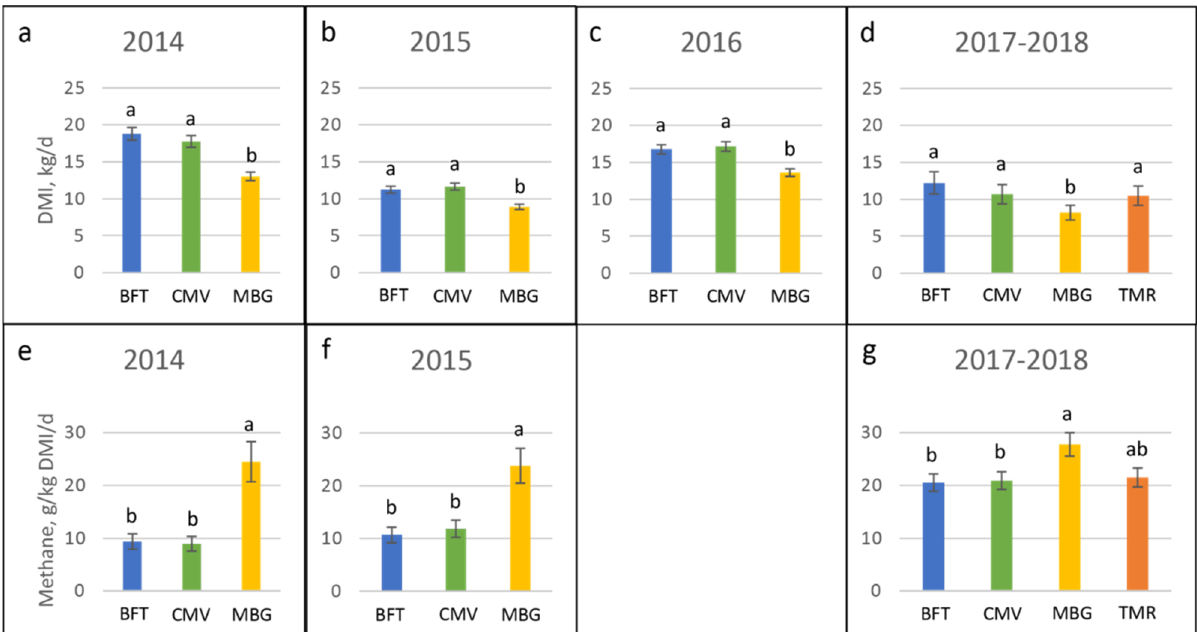
Figure 3. ( a – d ) Least squares means (LSMEANS) of daily dry matter intake (DMI) based on forage quality and body weight and ( e – g ) methane (CH 4 ) emissions as a function of DMI for ( a , e ) pregnant cows (653 kg) in 2014, ( b , f ) yearling calves (439 kg) in 2015, ( c ) dry cows (659 kg) in 2016 and ( d , g ) 2-year-old heifers (562 kg) in 2017–2018 on the three pasture treatments (BFT, birdfoot trefoil; CMV, cicer milkvetch; MBG, meadow bromegrass) and on a confinement total mixed ration (TMR) in 2017 and 2018. Data for DMI and CH 4 were analyzed separately for 2014 and 2015 and combined for 2017 and 2018; no CH 4 data were collected in 2016. Error bars are standard errors of the estimate. LSMEANS for each treatment within each year with the same letter are not different at α = 0.05 ( a – c ). Error bars represent ± SEM. Table 4. Intake, retention and output of nitrogen (N) in urine and feces in 2017 and 2018.